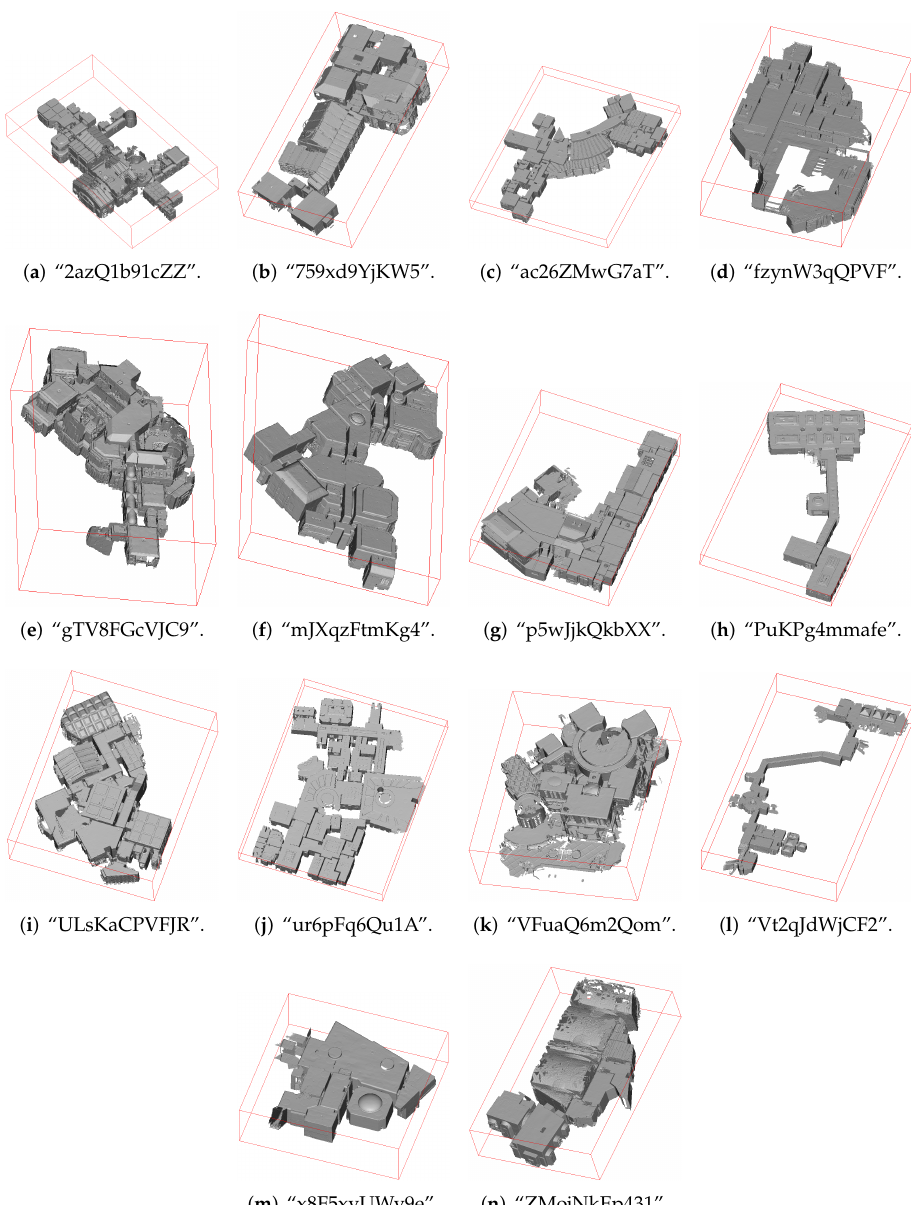
Figure 15. The triangle meshes of the Matterport3D dataset [90] used for evaluation. The red box indicates the aligned ground truth